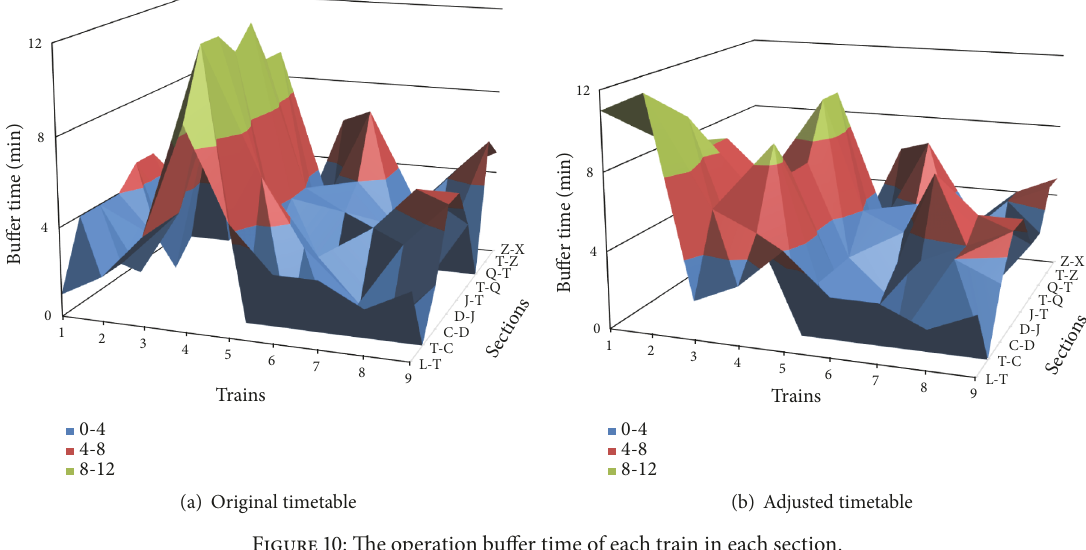
Figure 10: The operation buffer time of each train in each section.